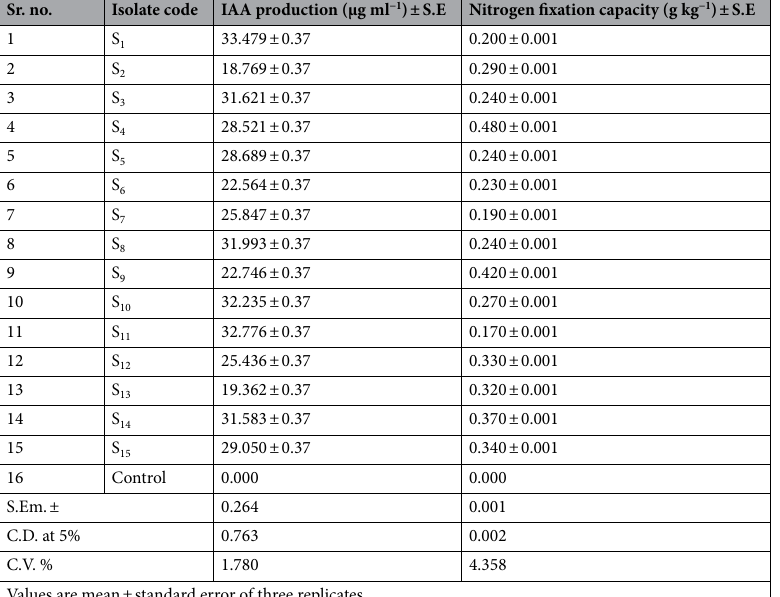
Table 5. Indole acetic acid production and nitrogen fixing capacity of isolates.